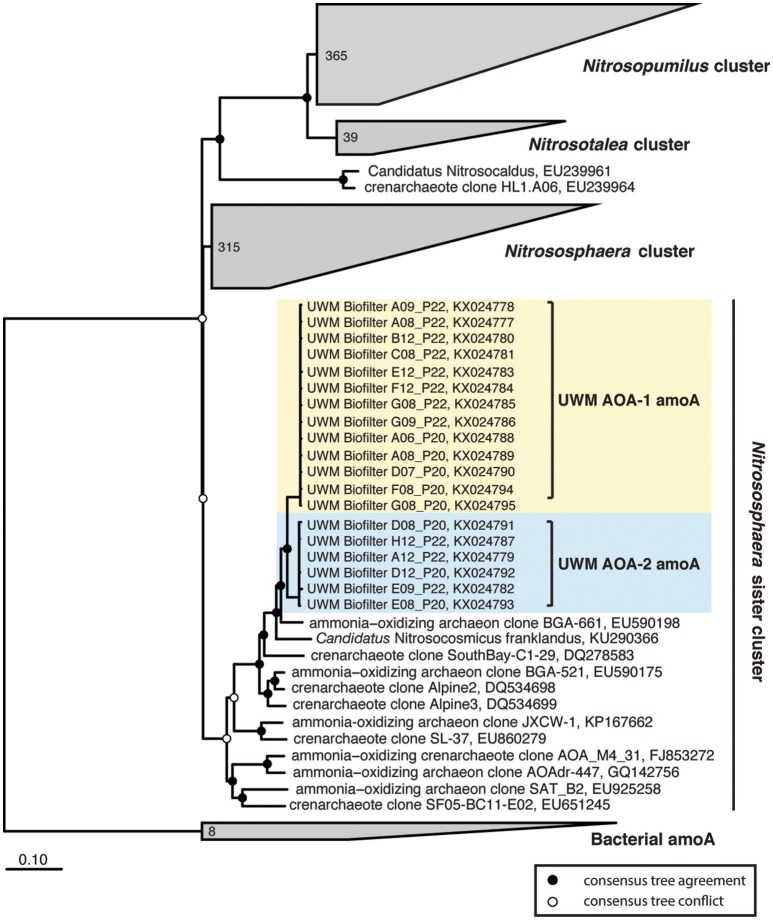
Ammonia-oxidizing Archaea consensus tree. A consensus phylogenetic tree was generated from maximum likelihood and Bayesian inference phylogenetic reconstructions. Consensus tree support is indicated by colored circles at tree nodes. Collapsed nodes and assigned names are based off of Pester et al. (2012). Clone and taxonomic names are followed by NCBI accession numbers. Ammonia-oxidizing archaea amoA sequences generated in this study are highlighted.